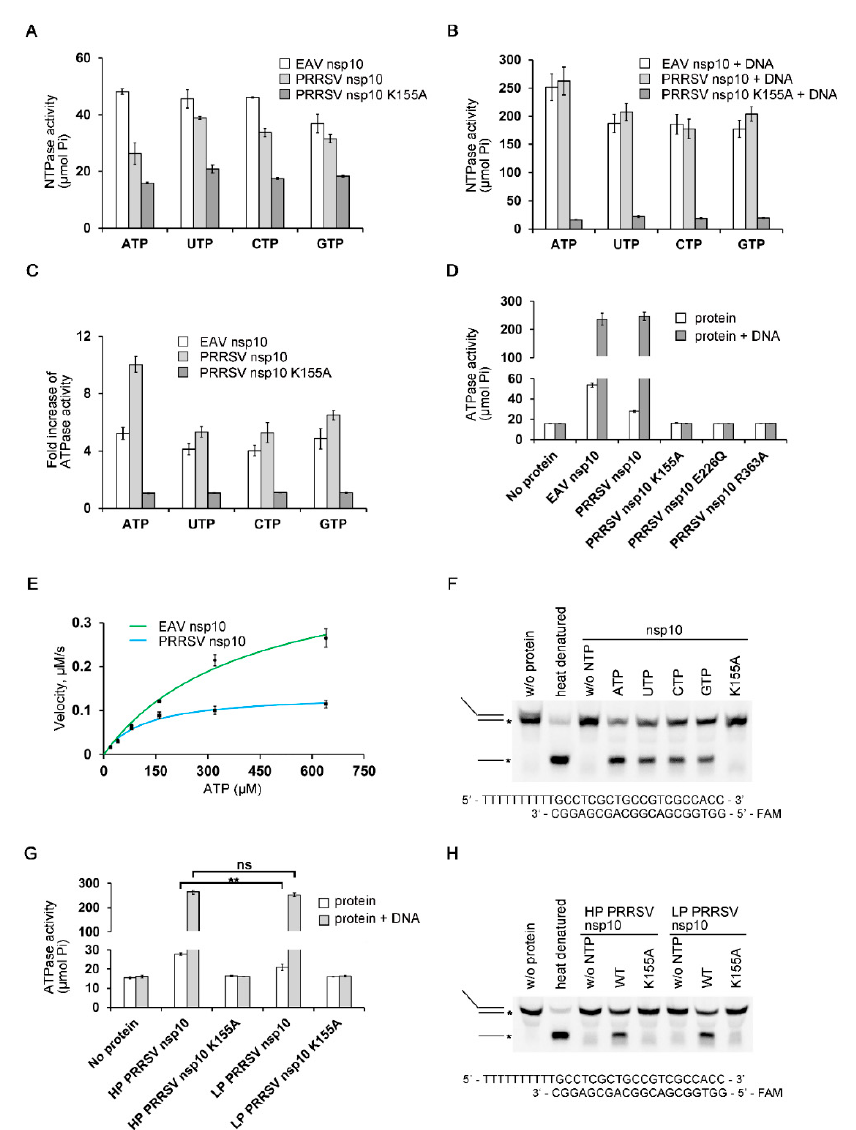
Figure 2. PRRSV nsp10 in vitro enzymatic activity assays. ( A ) NTPase activity of PRRSV nsp10 in the absence of nucleic acid substrate. HP-PRRSV nsp10 is called as PRRSV nsp10 unless otherwise specified. The final concentration of protein was 5 nM unless noted. ( B ) NTPase activity of PRRSV nsp10 in the presence of partially double-stranded DNA. ( C ) E ff ects of nucleic acid substrate on the ATPase activity of nsp10. ( D ) ATPase activities of di ff erent nsp10 variants compared with the activity of WT nsp10. ( E ) Determination of the kinetic parameters of ATPase reactions. A plot of velocity versus ATP concentration in ATPase reactions for nsp10 and equine arteritis virus (EAV) nsp10 is shown. The final concentrations of PRRSV nsp10 and EAV nsp10 were 20 nM. ( F ) Helicase assay shows that PRRSV nsp10 can utilize di ff erent NTPs to unwind dsDNA. ( G ) ATPase activity comparison of HP-PRRSV nsp10 and low pathogenic PRRSV (LP-PRRSV) nsp10. ( H ) Unwinding activity comparison of HP-PRRSV nsp10 and LP-PRRSV nsp10. No enzyme ( w / o protein) and heat denatured controls are indicated. DNA strand with FAM label is marked with an asterisk. Error bars represent SD values from three separate experiments. ** P < 0.01; ns, not significant (Student’s unpaired t